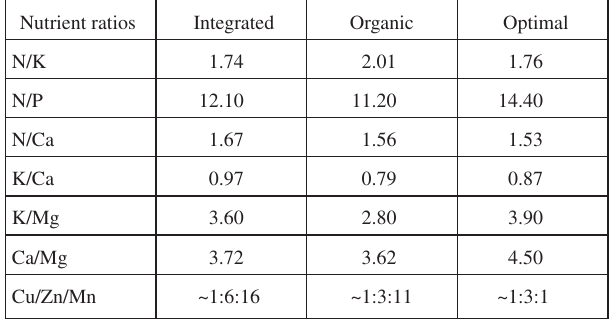
Table 3. Nutrient ratios in apple leaf (Pallag, 2002–2004, averages of cultivars at standard sampling time) Nutrient ratios Integrated Organic